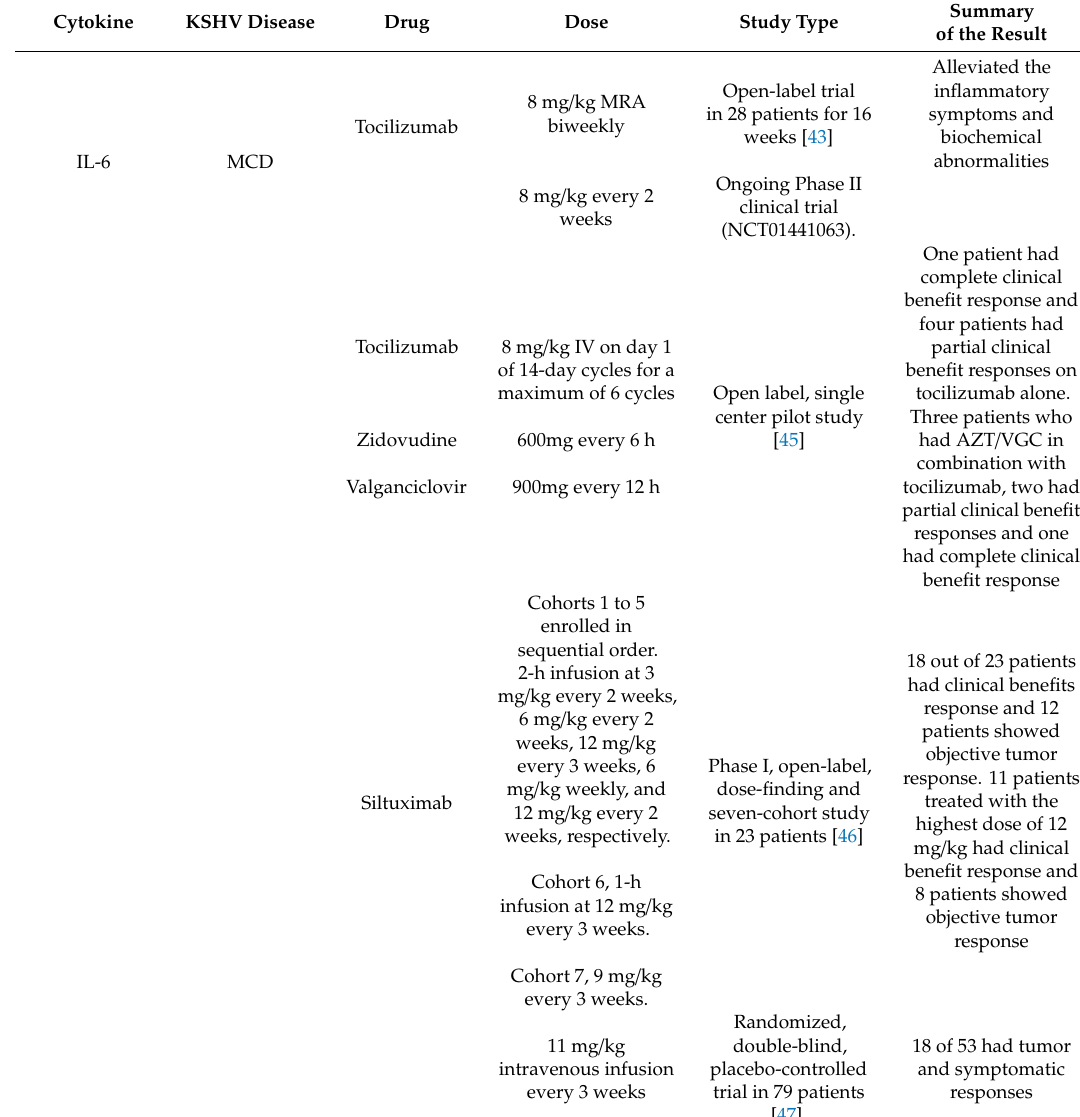
Table 1. Summary of the clinical trials referenced in this